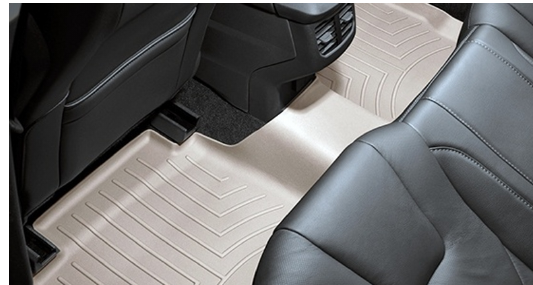
Figure 2. Car mat of the Ford Lincoln made of banana fiber